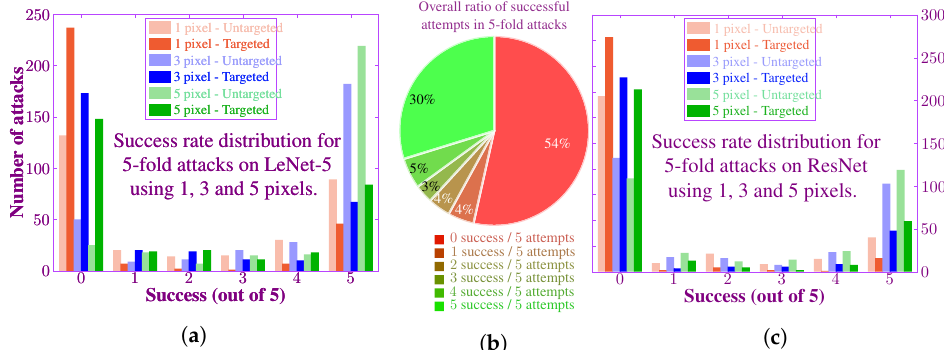
Figure 11. Statistics of the attack success rate for all experimental scenarios. ( a ) The histogram shows the success rate distribution in 5-fold attacking experiments for LeNet-5. Random images from the CIFAR-10 test dataset are attacked five times each using 1,3 and 5-pixels, and the number of successful attempts is recorded as shown in the histogram. The targeted attacks have a lower success rate as compared to untargeted attacks. Additionally, as the number of attacked pixels increases, the success rate also improves. ( b ) The proportion of successful and unsuccessful attacks for all of the experiments. ( c ) Success rate distribution for ResNet in both targeted and untargeted